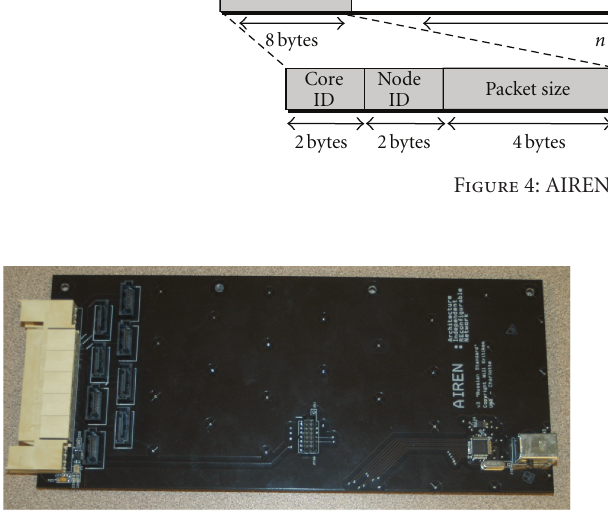
Figure 5: AIREN network